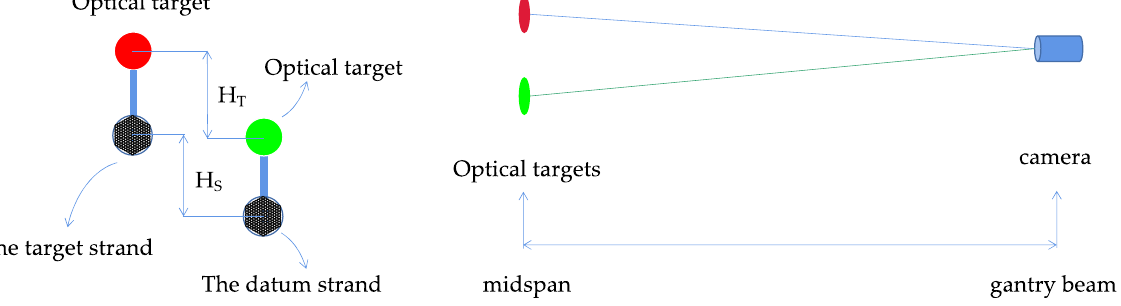
Figure 3. Measurement principle of the proposed method.